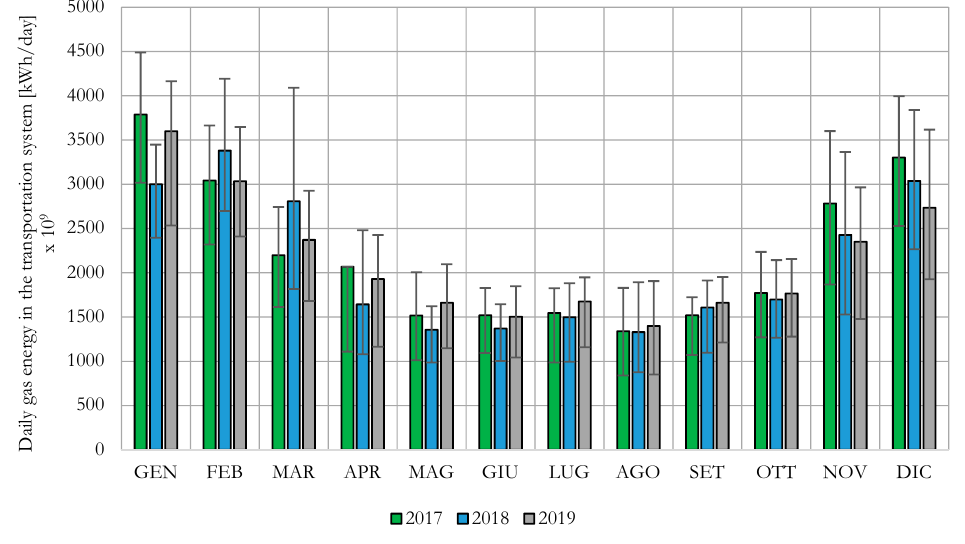
Figure 4. Average daily gas energy in the transportation system during 2017, 2018 and 2019. Data elaborated from [47].